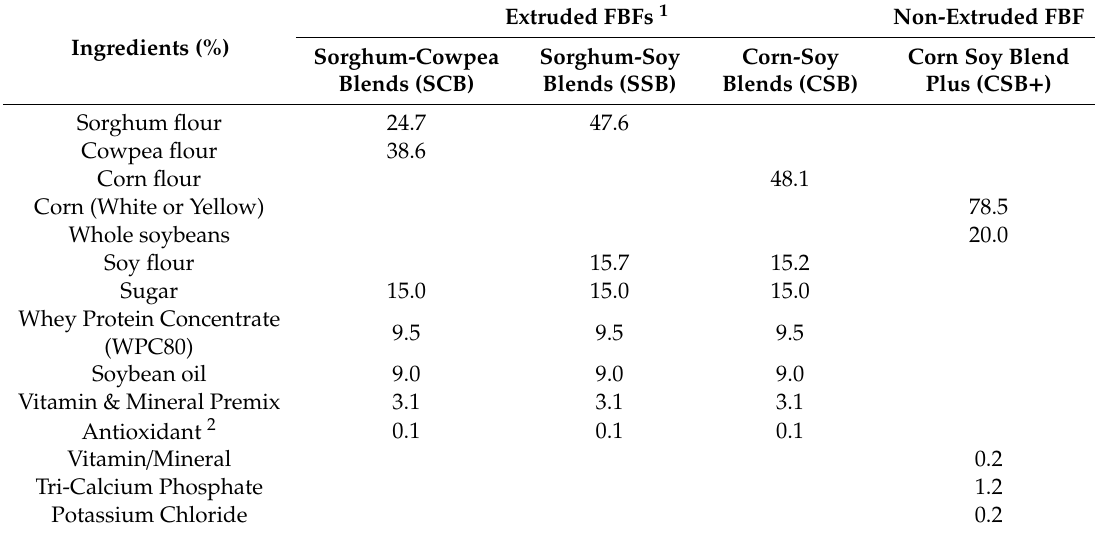
Table 2. Composition of extruded FBFs and non-extruded